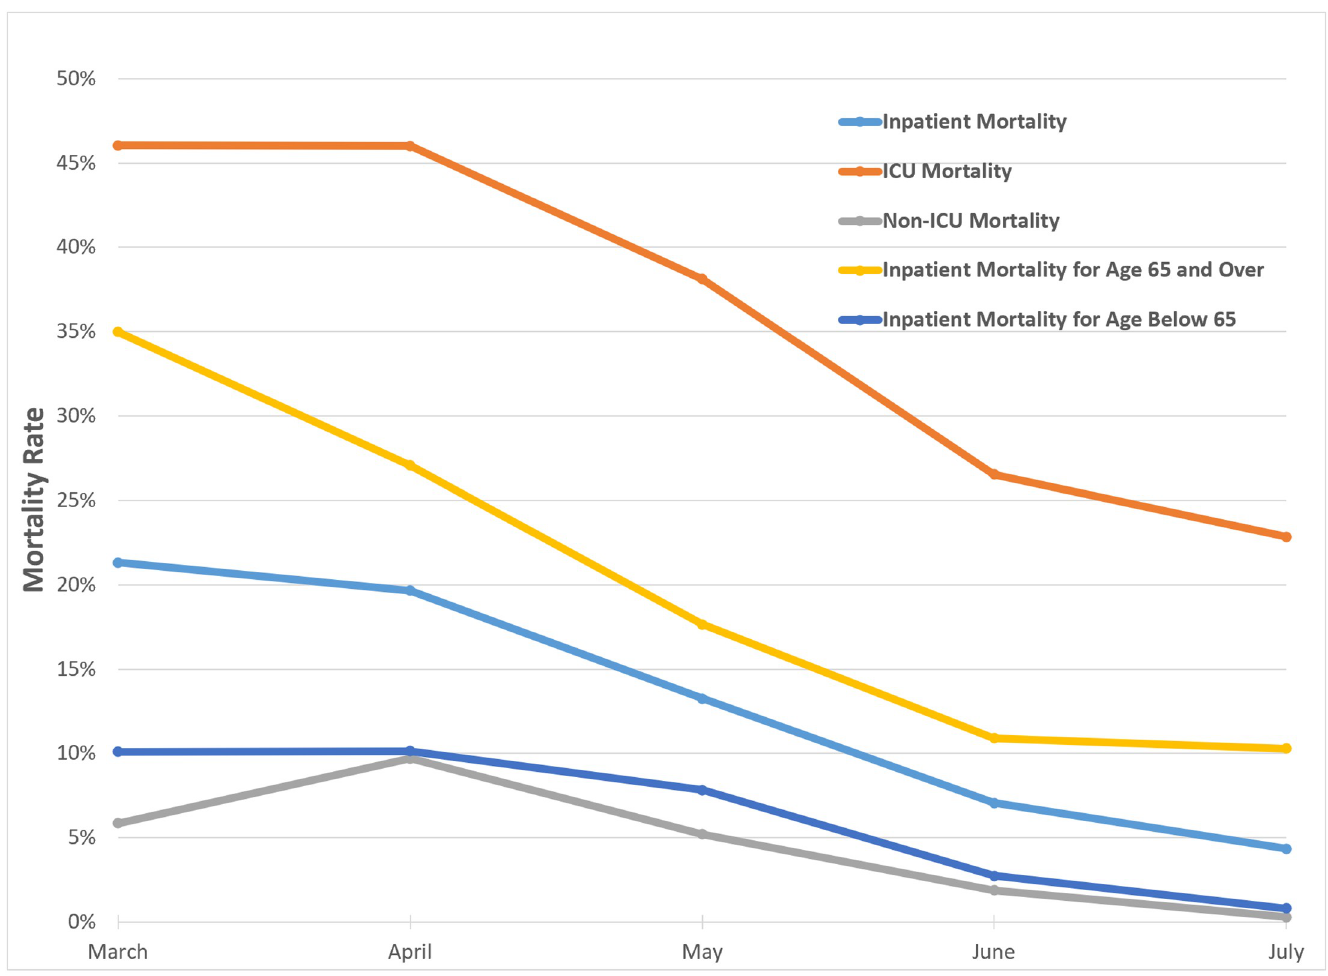
Fig 1. Mortality Trends in COVID-19 admissions. During the study period, overall mortality declined in the healthcare system. A decline was also seen regardless of stratification by age or level of care.